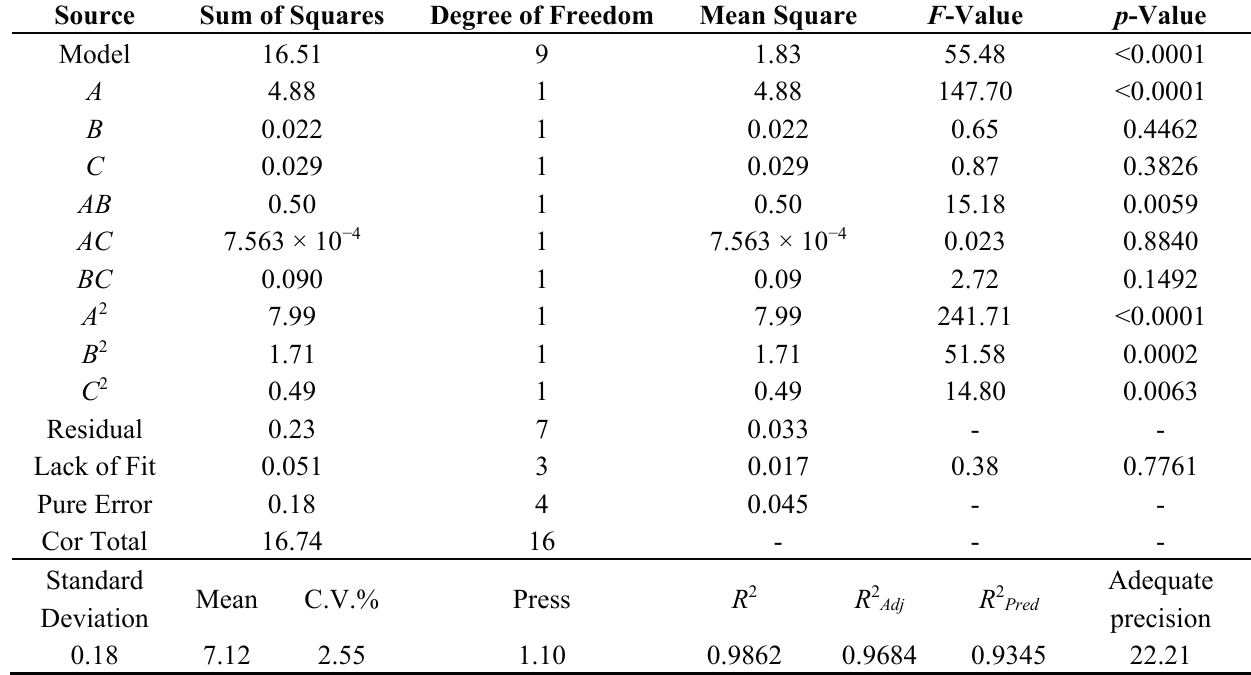
Table 2. Analysis of variance (ANOVA) of the experimental results of the